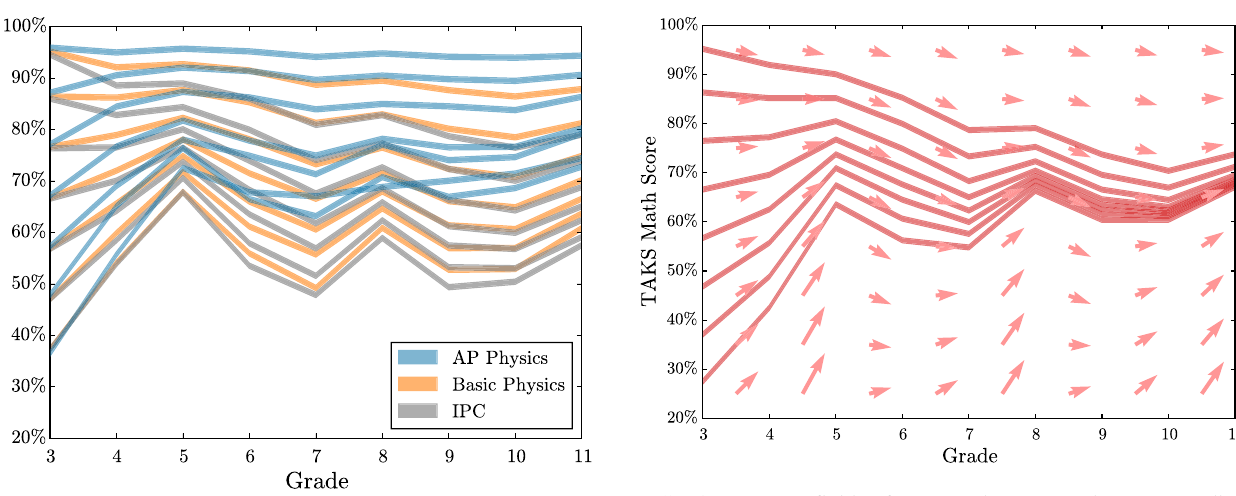
FIG. 3. Trajectories for the cohort of 2012 disaggregated by the highest level of physics course taking. Despite having similar 3rd grade scores, AP physics students outperform their basic physics and IPC counterparts.